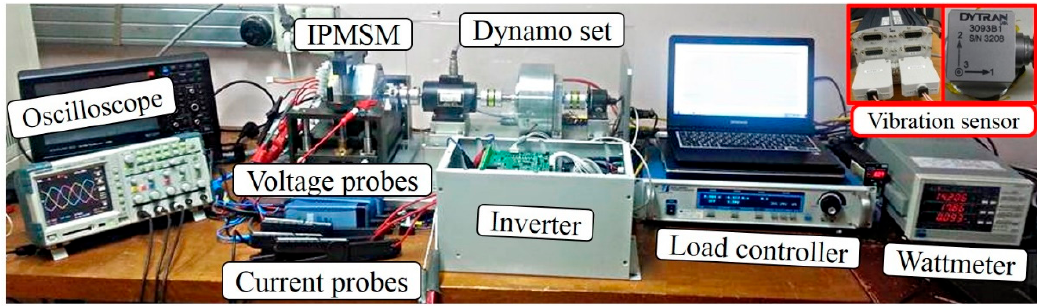
Figure 9. Frequency spectrum of the stator current under BF. Table 1. Parameters of the benchmark PMSM.